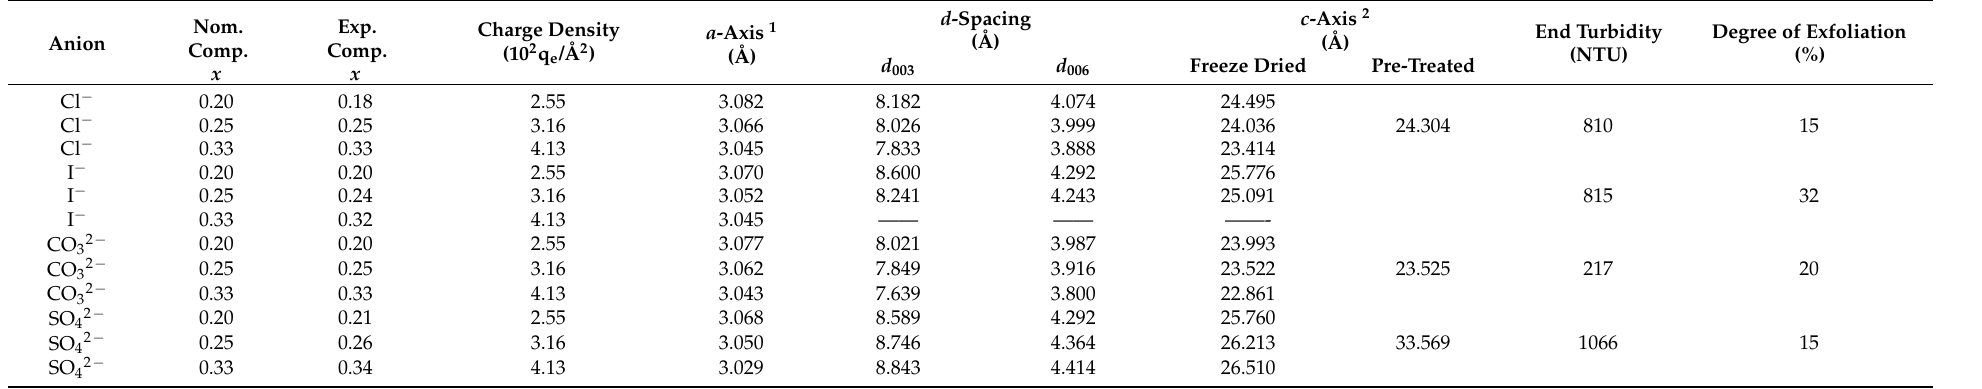
Table 2. Chemical composition, layer charge, unit cell dimensions, and exfoliation properties of Mg 1 − x Al x (OH) 2 ( A n − ) x/n · m H 2 O with A n − anions = Cl − , I − , CO 32 − , SO 42 − . Nom. Anion Comp. x Cl